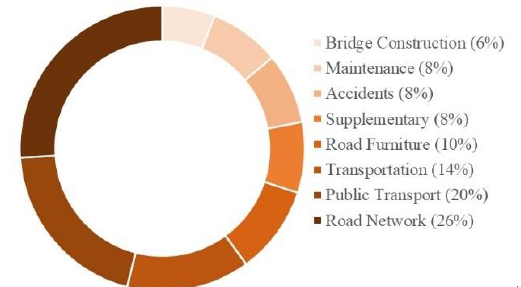
Figure 6. Allocation of developed specialized functionalities.